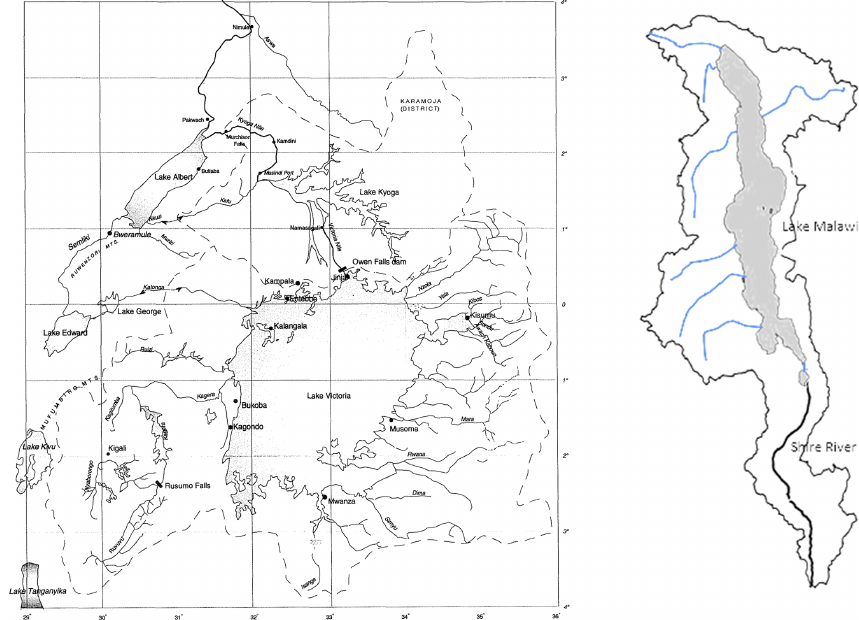
Figure 1. Map of the Lake Victoria region (Source: IAHS Press and Sutcliffe and Parks, 1999) (left) and Lake Malawi